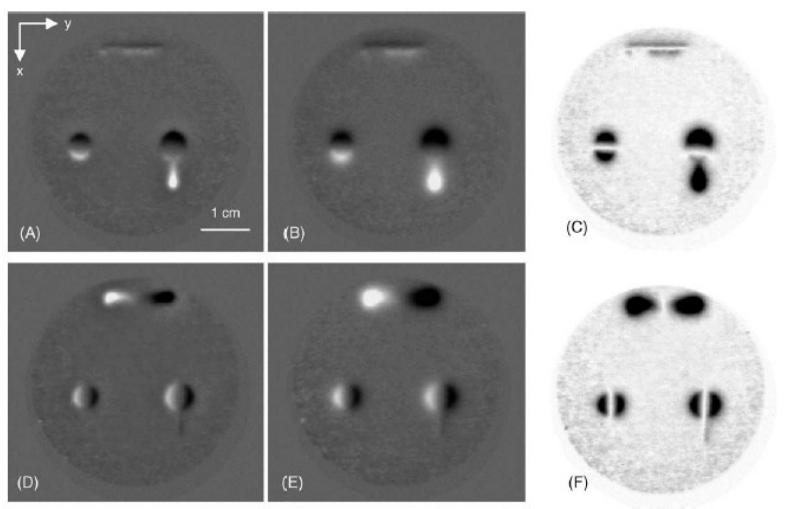
Figure 25. EC-MO images of a two layer riveted lap